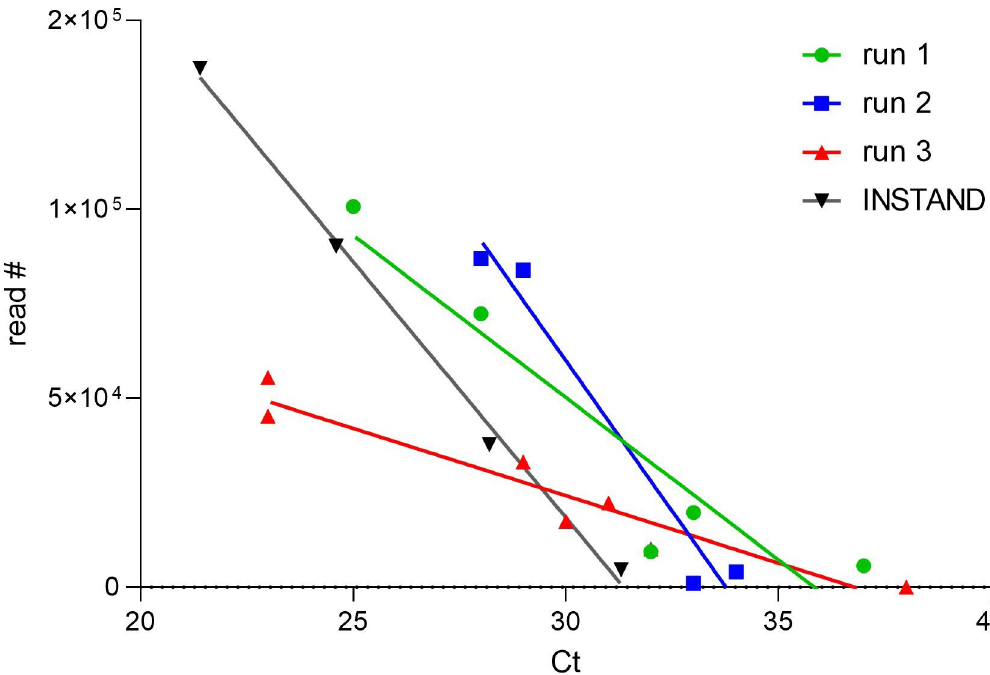
Fig 1. Correlation of SARS-CoV-2-specific reads obtained by RespiCoV (shown for three different sequencing runs) and the Cq value generated by a specific real-time PCR assay. Even if accurate quantification by RespiCoV is questionable, within one run the correlation is significant (R squared: 0.88, 0.96, 0.91, and 0.99 for run 1, run 2, run 3, and the INSTAND samples, respectively).